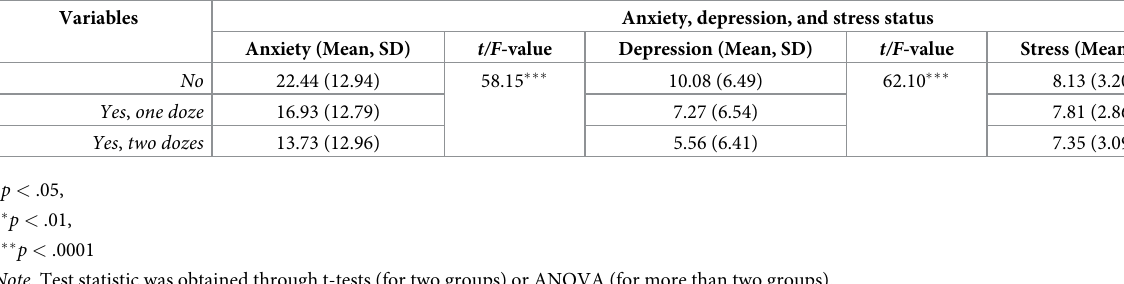
We report the results of multivariate regression analyses in Tables 3–5. For anxiety, nonmodi- fiable predictors jointly accounted for 19% of the variances, with sex, age, education, division, and living place emerging as significant predictors (Model 1). The second model incorporated modifiable predictors, accounting for 33% of the variance in the anxiety scores, a significant increase of 14% attributable to modifiable factors. Female gender ( B = 0.31, 95% CI : 0.17, 0.46), secondary education ( B = -0.31, 95% CI : -0.61, -0.01), division (Rajshahi [ B = 0.38, 95%